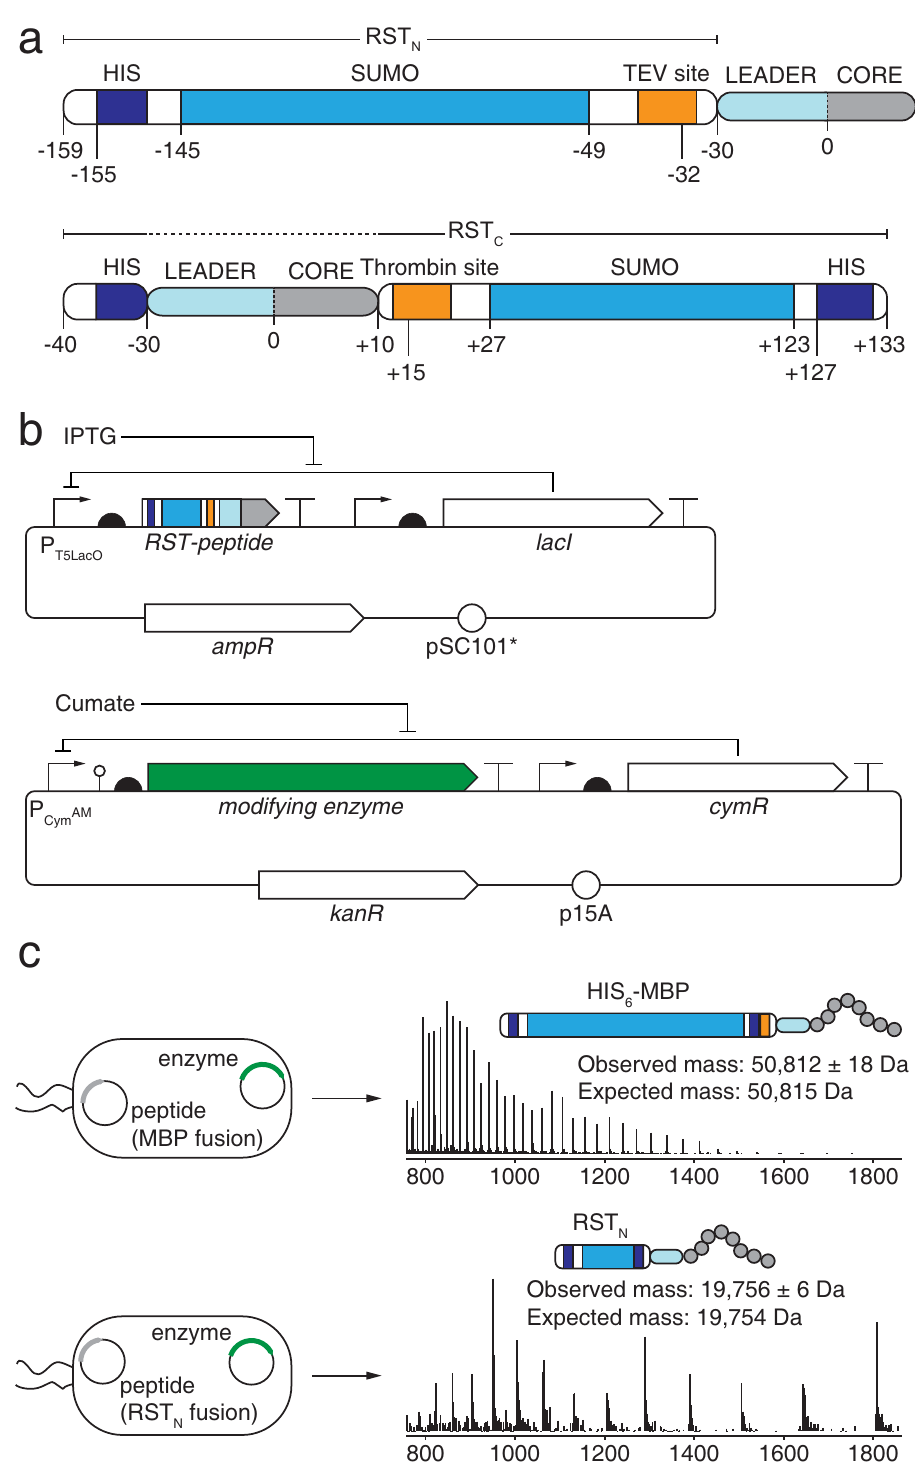
Fig 1. Expression system for producing modified peptides. a Schematic of the RSTs. Sequences for the backbones are in S8 Table, part sequences in S7 Table. b The two-plasmid system used to express the RiPP peptide and modifying enzyme. The genetic part sequences are provided in S7 Table. c The extracted peptides were analyzed using LC-MS to observe the mass shift associated with the modification. The tags used are shown above the spectra. The